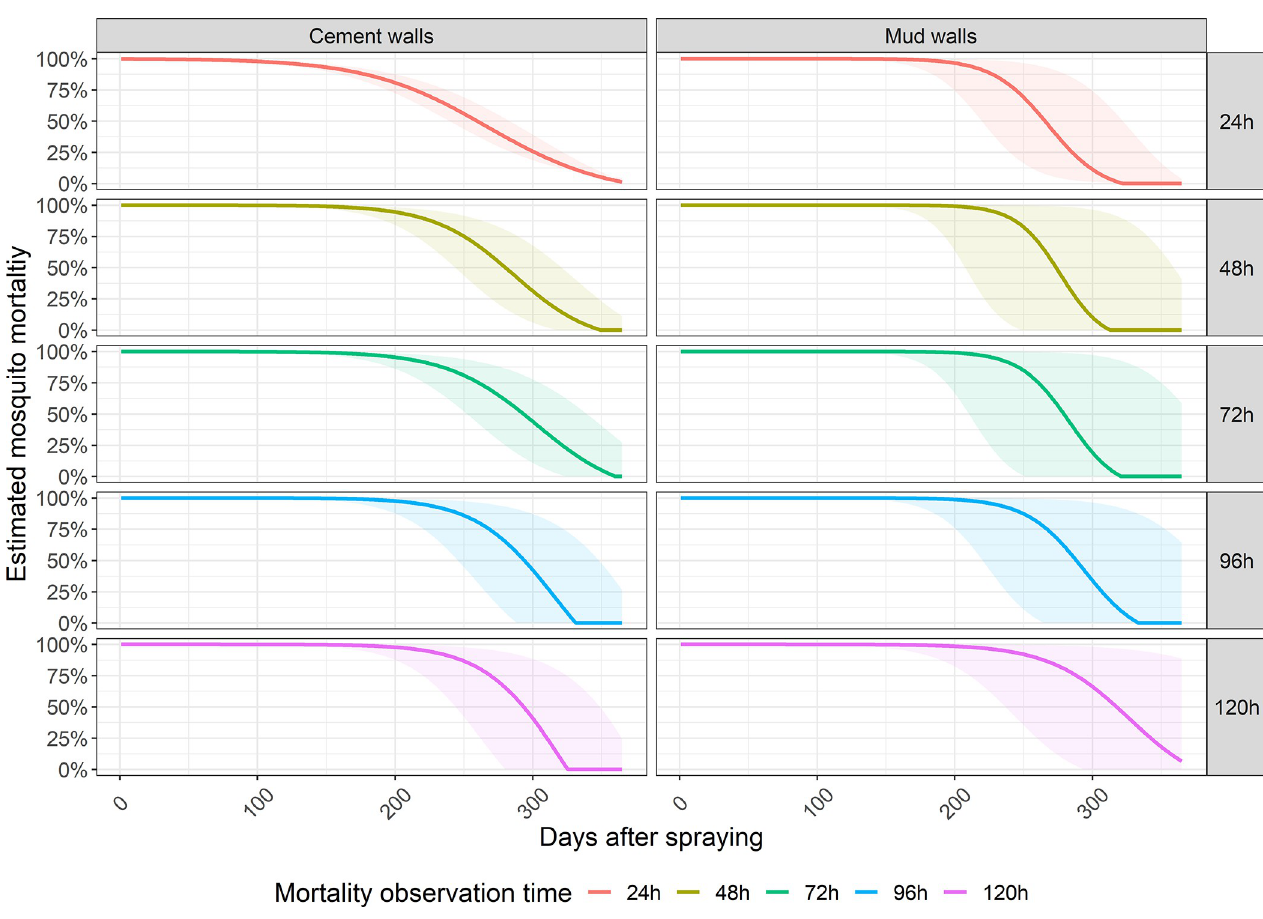
Fig 3. Estimated Abbott’s corrected mosquito mortalities 24h-120h after exposure to mud or cement walls sprayed with Actellic 1 300CS during the 2017 campaign in Magude district.